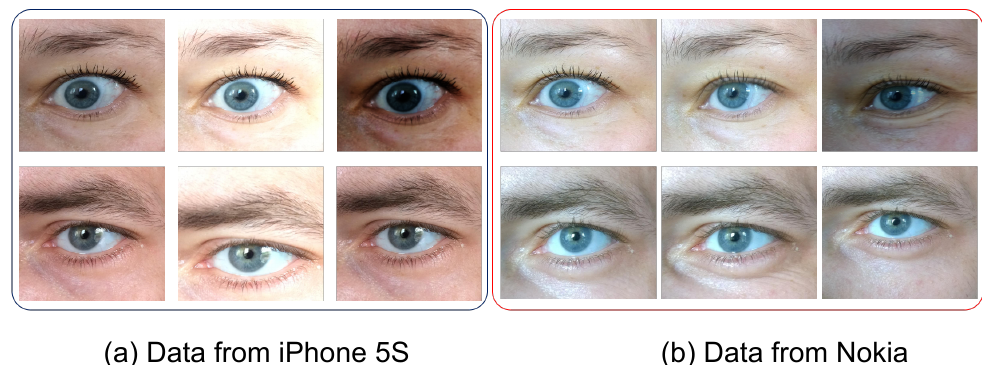
Figure 2. Sample images from the periocular database